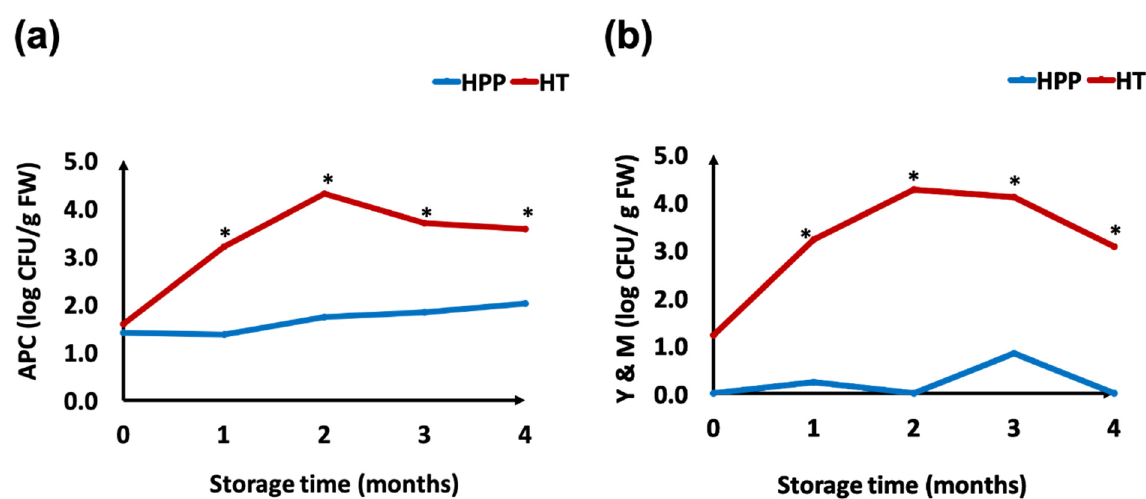
Figure 2. Microbial counts of high pressure processing (HPP, 600 MPa, 3 min) and heat treated (HT, 63 °C, 3 min) puree samples during a 4-month refrigerated storage period: ( a ) total aerobic plate counts (APC); ( b ) yeast and mold counts (Y&M). Denotation of “*” indicates significant differences between treatments at each sampling point.